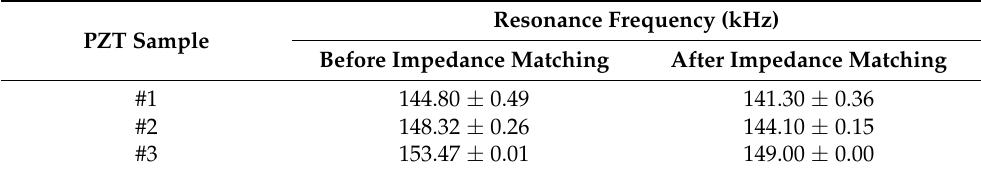
Table 3. Resonance frequencies of piezoelectric ceramics (PZTs) before and after impedance matching.